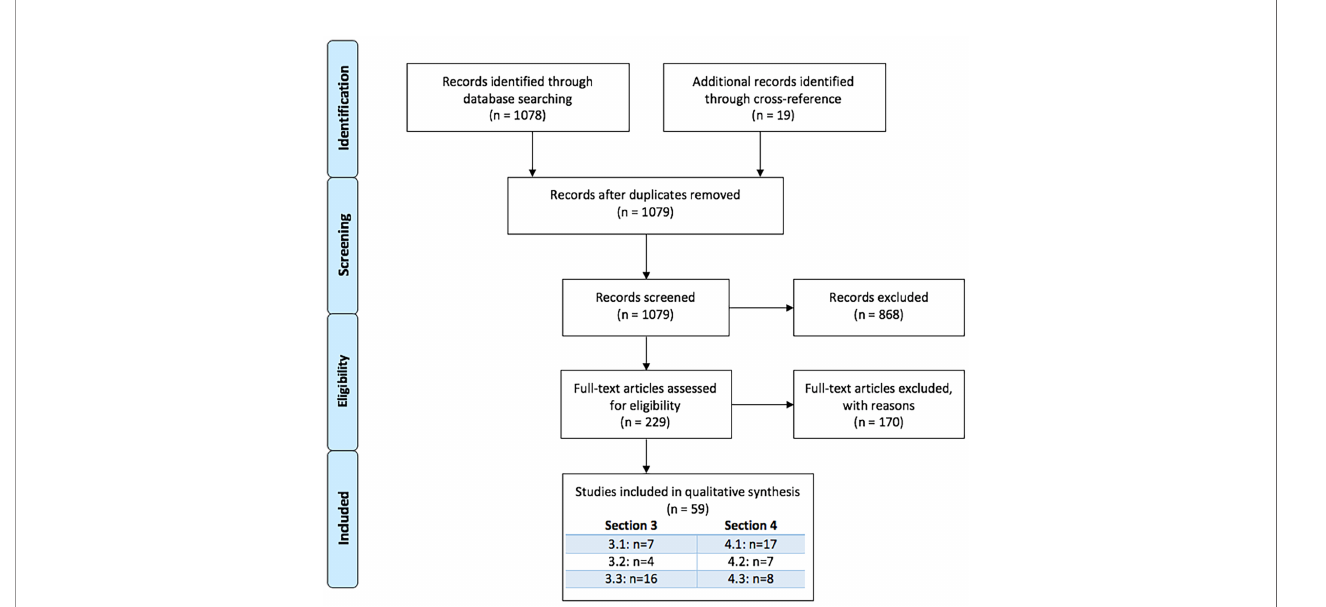
FIGURE 2 | PRISMA fl